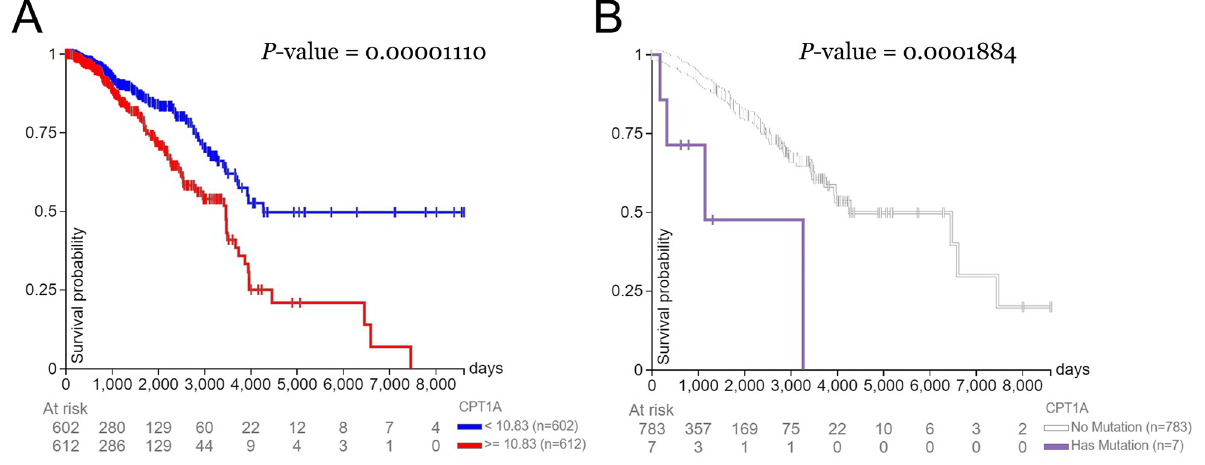
Fig 1. Days after initial treatment vs. survival probability. Correlations between days after initial treatment and survival probability in breast cancer patients (A) with high ( > = 10.83 RKMP) vs. low ( < 10.83 RKMP) expression levels of CPT1A and (B) with or without mutations in CPT1A .